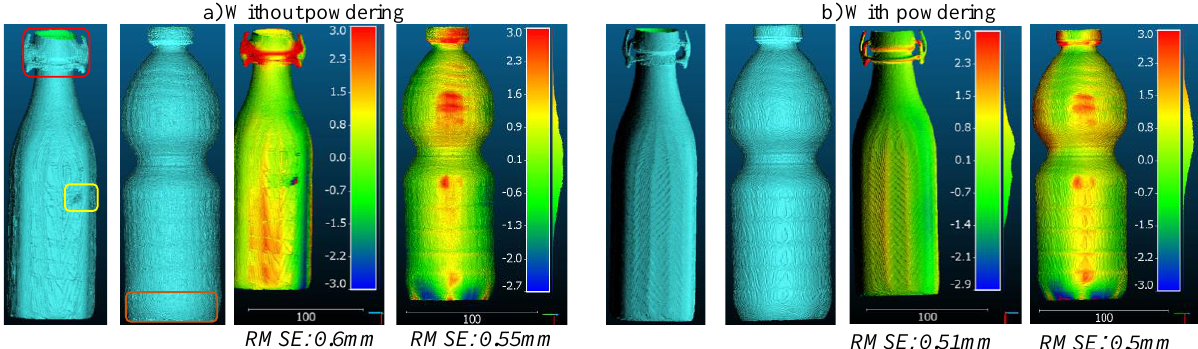
Figure 3. Quantitative analyses for the SFS-based 3D results on the two transparent objects of Figure 1. Using the 3D data achieved with photogrammetry on the powdered objects (Figure 1), the RMSE of a cloud-to-cloud comparison is